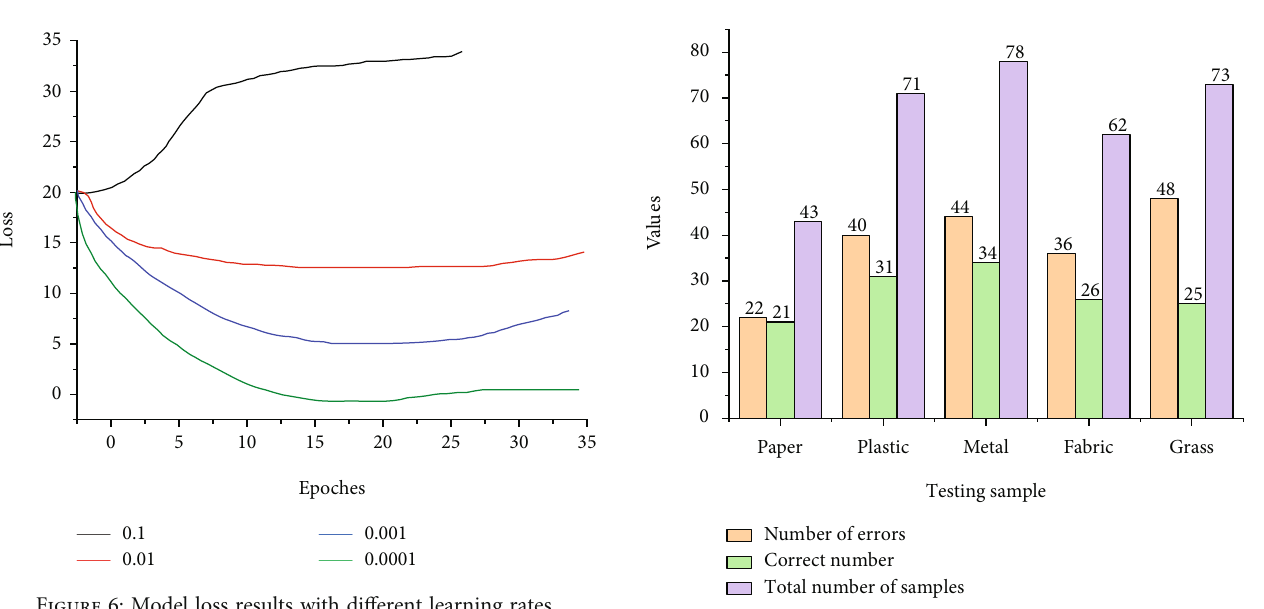
Figure 8: Cost results, in the fi gure, the values under di ff erent types are